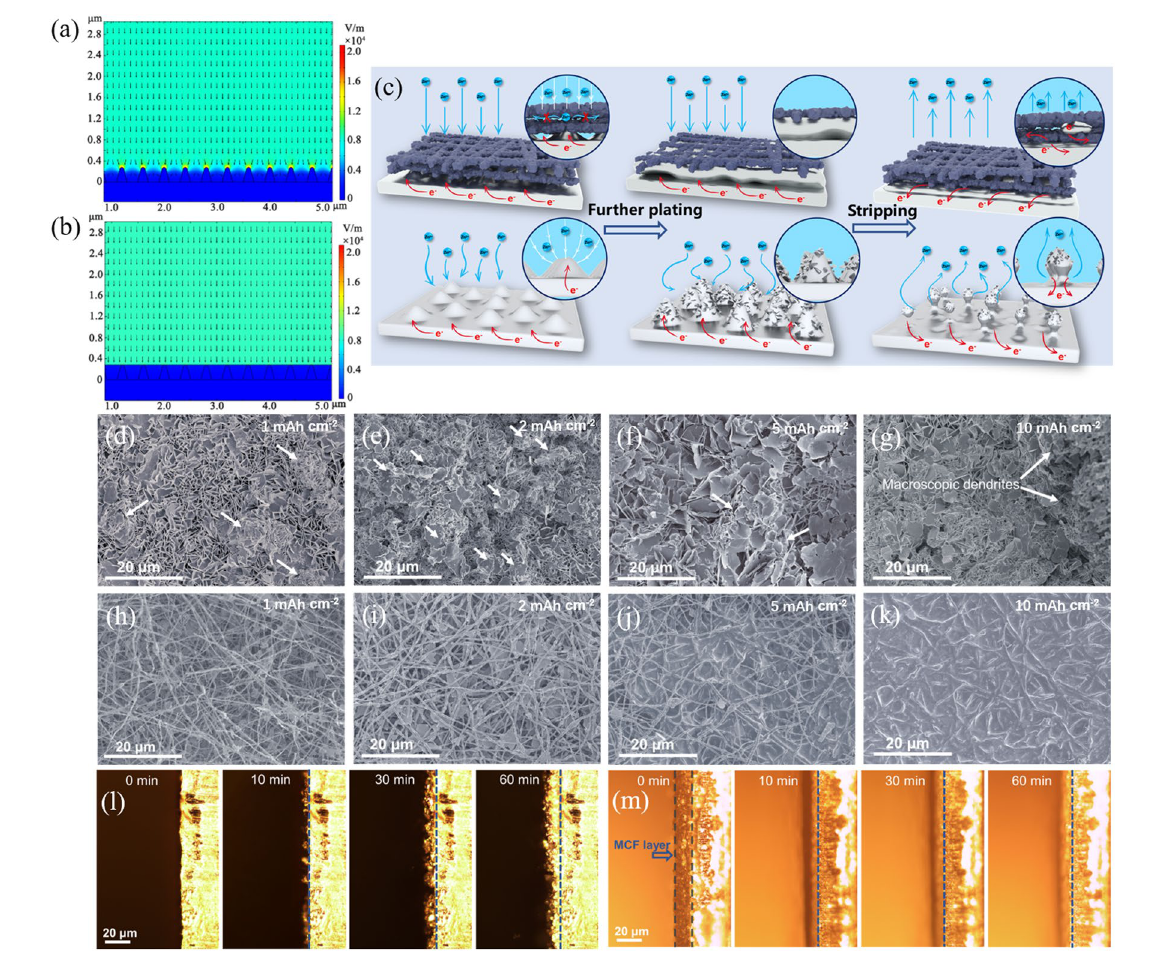
Fig. 2 Multiphysics simulation models of the electric field distribution for a bare Zn and b Zn@MCFs. c Illustration of Zn plating/stripping behavior on bare Zn (lower) and Zn@MCFs (upper). Ex situ Zn deposition observation with capacities of 1, 2, 5, and 10 mAh cm −2 for d–g bare Zn, and h–k Zn@MCFs. In situ observation of Zn deposition at 5 mA cm −2 after 0, 10, 30, and 60 min for l bare Zn, and m